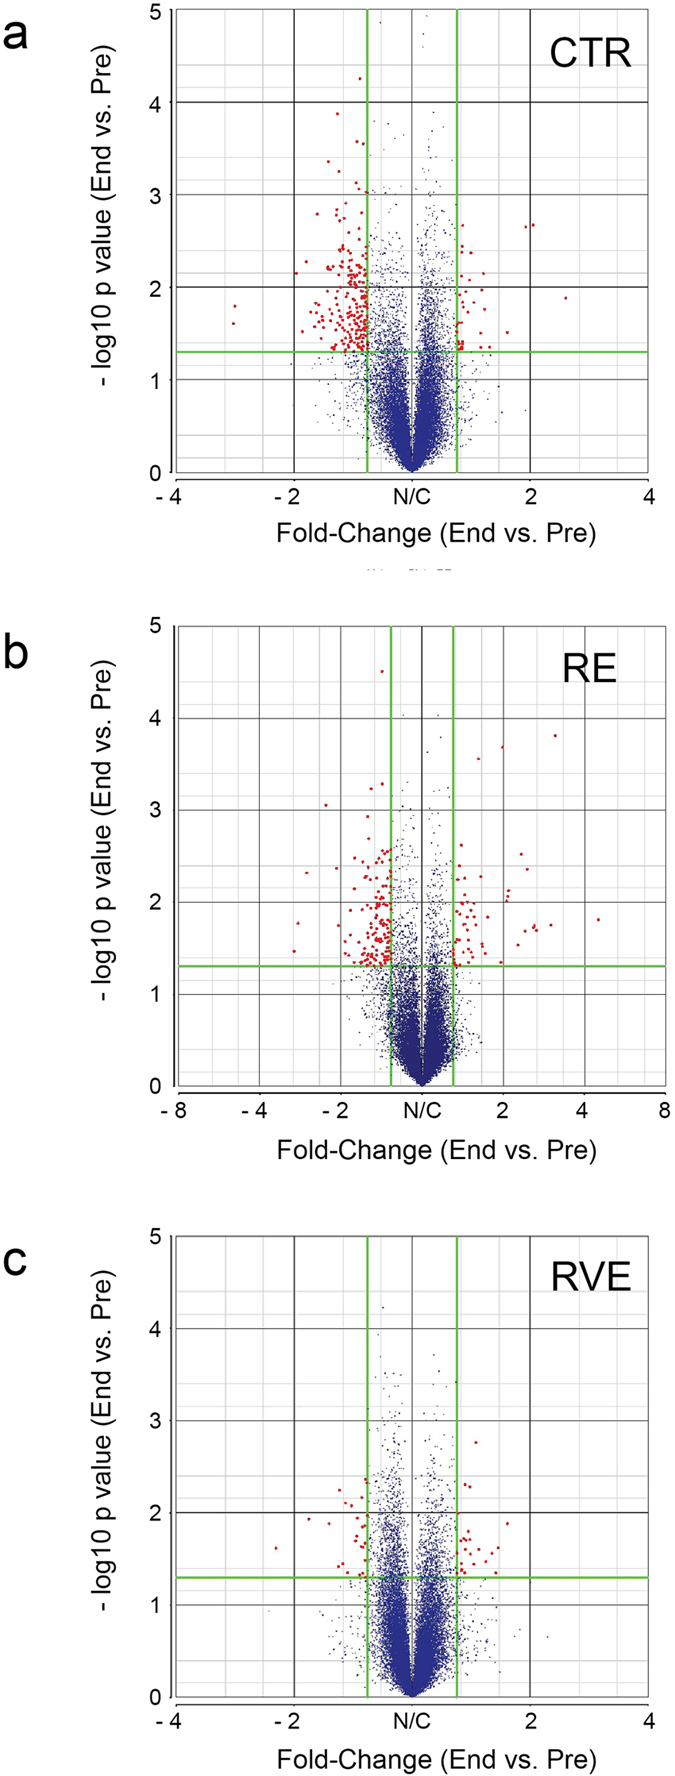
Effect of RE and RVE countermeasures on muscle-specific gene expression rearrangement after 60 days of bed rest.Volcano plots obtained by comparing end vs. pre skeletal muscle (SOL) biopsies (matched samples) in CTR, RE and RVE groups showing gene expression regulation in solei of bed rest subjects. Disuse-induced gene changes in CTR (a), RE (b) and RVE (c) groups given as single dots (red/blue color-coded) located within the area delineated by fold changes criteria. The different pattern of dots in each group reflect the differential gene profile outcome (red = significant change, blu = no change) for each intervention following long-term bed rest. Red dots represent significantly changed transcripts (p < 0.05) meeting < − 1.3 and >1.3 fold change cut off. Blue dots = changes below the cut off.